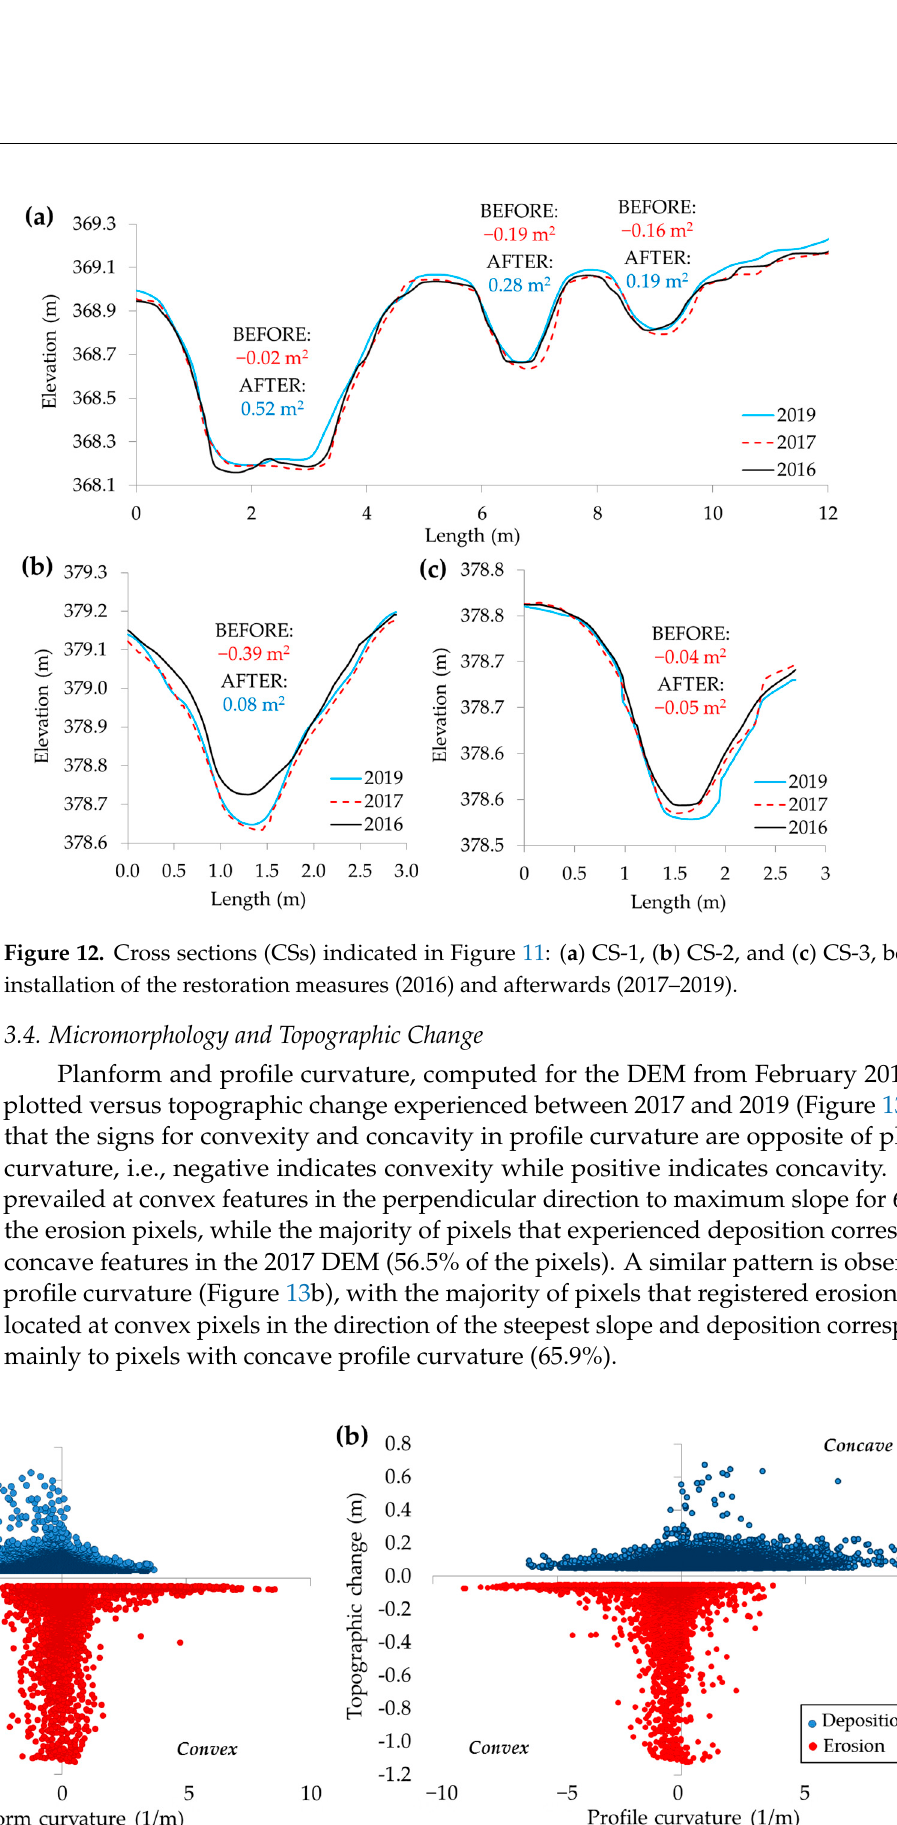
behind check dams for P2 and P3, respectively. The results indicate that deposition be- hind check dams during P2 and P3 mostly took place on concave and flat surfaces, due to the filling of previously concave areas. The deposition during P2 prevailed on concave areas for 44% of the pixels. The deposition during P3 predominated on concave areas for 38% of the pixels. These results indicate an increase of convexity and the transition from concave to plan and/or convex morphology behind the check dams. Figure 14. Profile curvature derived from 2017 digital elevation model (DEM) and compared to deposition behind check dams in P2 and in P3 by the DEMs of difference (DoD). The local slope gradient played an important role in determining whether a pixel will experience erosion or deposition. As expected, the initial slope at pixels that later experienced erosion was significantly higher than those that registered sedimentation (Figure 15), at a confidence level of 95%.